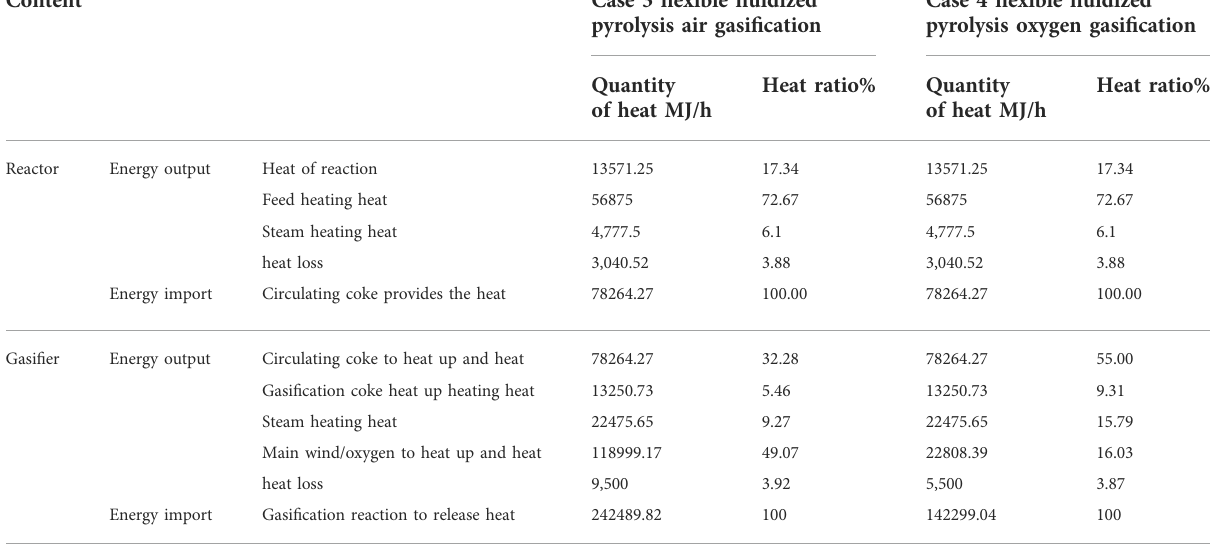
TABLE 5 Heat balance of the fl exible fl uidized pyrolysis process of the coal liquefaction residue.